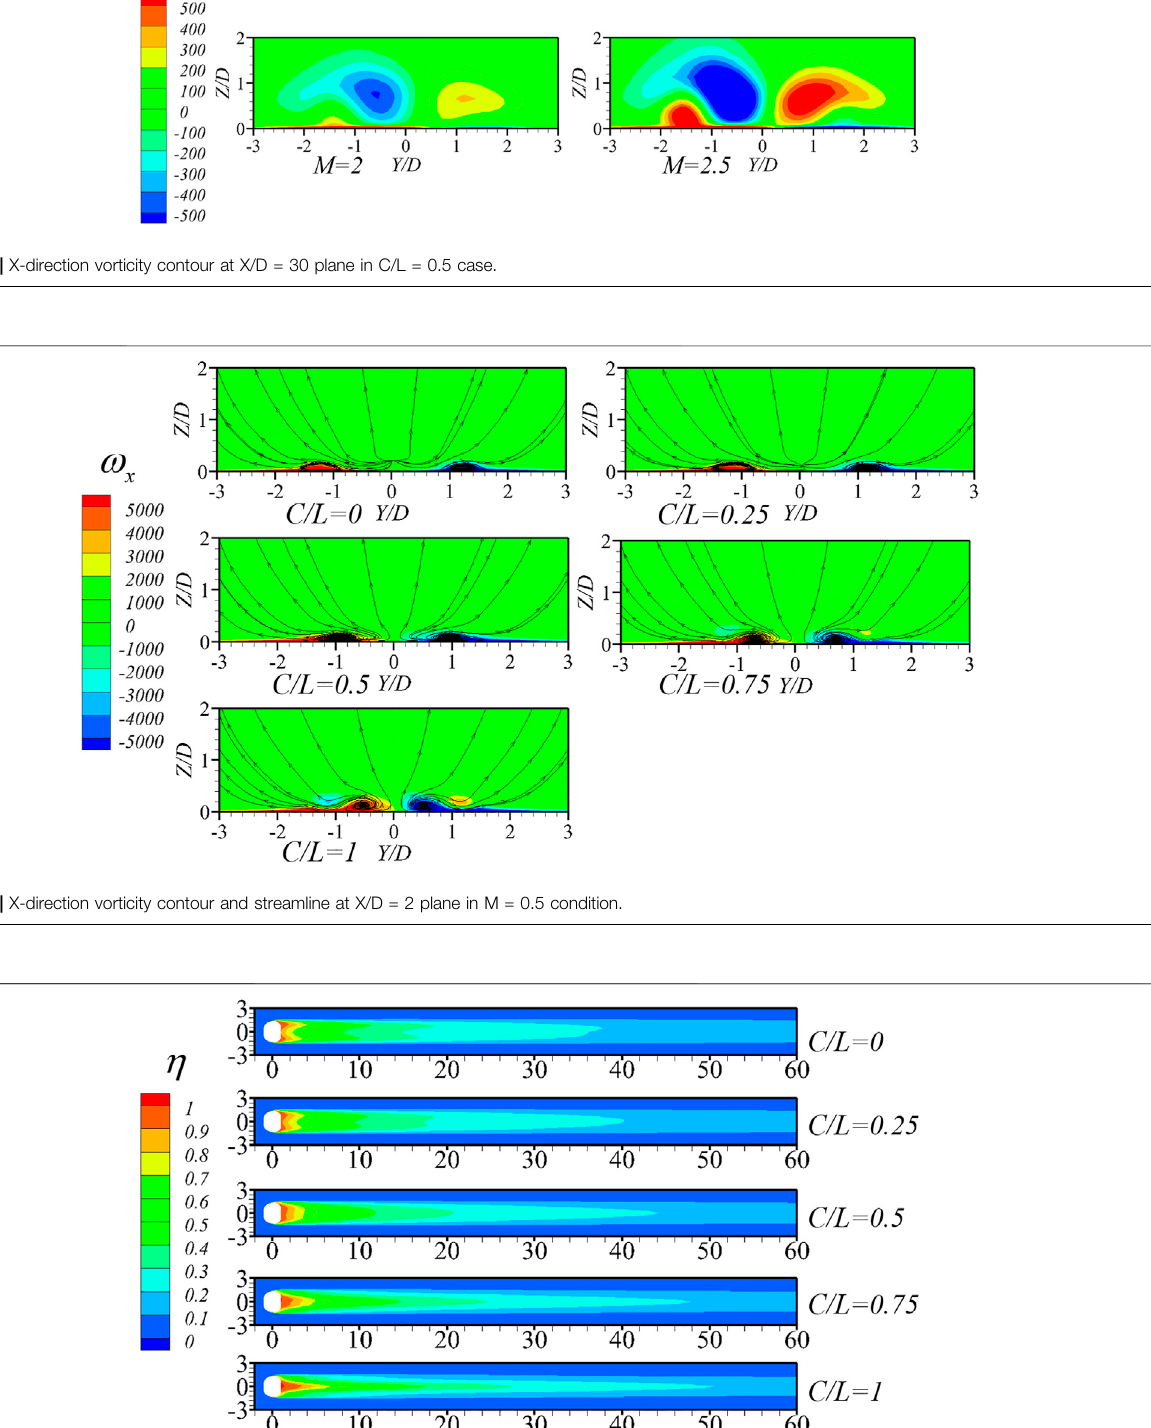
FIGURE 9 | Adiabatic cooling effectiveness contour in M (cid:2) 0.5 condition.